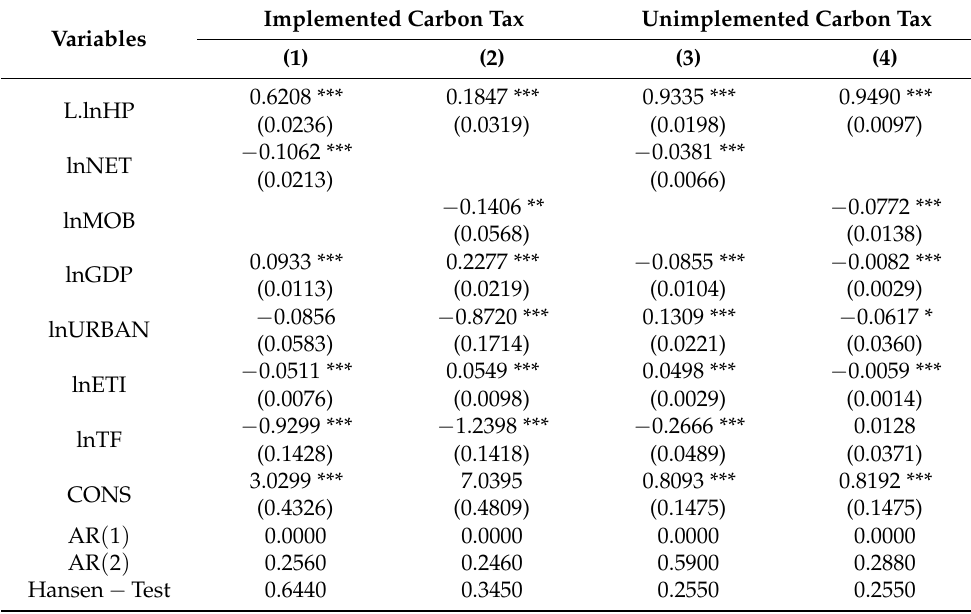
Table 5. Results of the heterogeneity test based on environmental